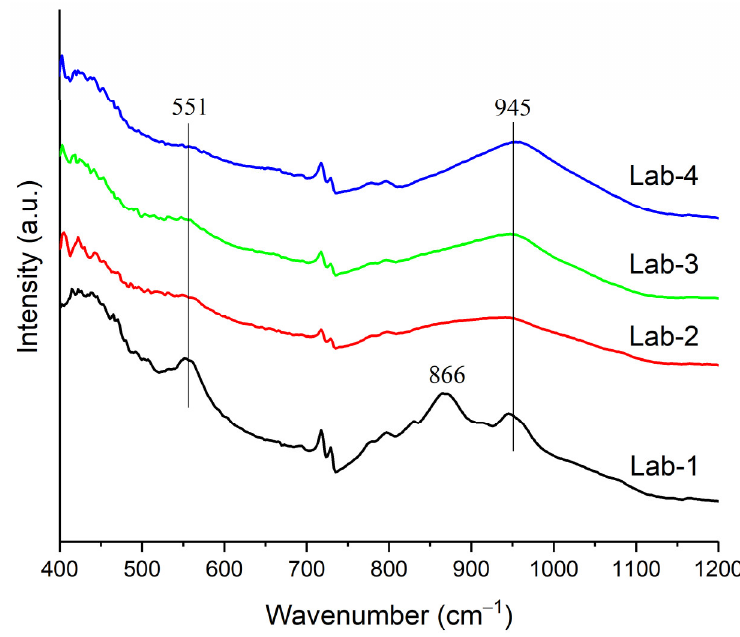
Figure 13. FTIR spectra of the spent catalysts following FTS reaction.